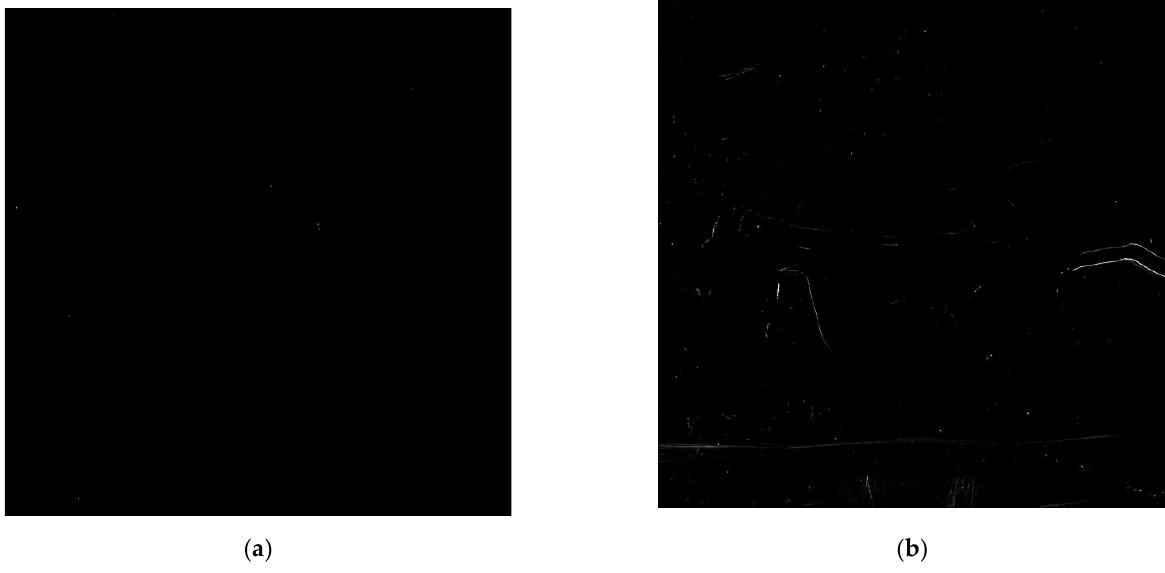
Figure 9. Dark field test results of surface damage and defects measured by an ultra-smooth surface laser scattering quality detection device. ( a ) Initial Surface Dark Field Test Results of Components after CMP; ( b ) Surface Dark Field Test Results after Sufficient Surface Hydrolysis.